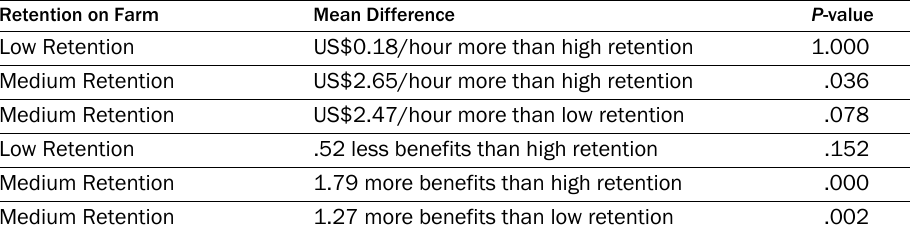
Table 7. Multiple Comparisons, Retention and Pay and Retention and Benefits Retention on Farm